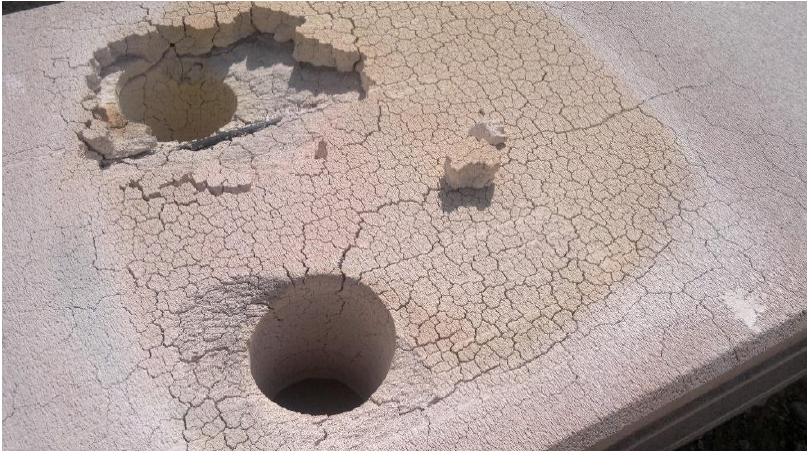
Figure 6. Autoclaved concrete (AAC) cracking and heat